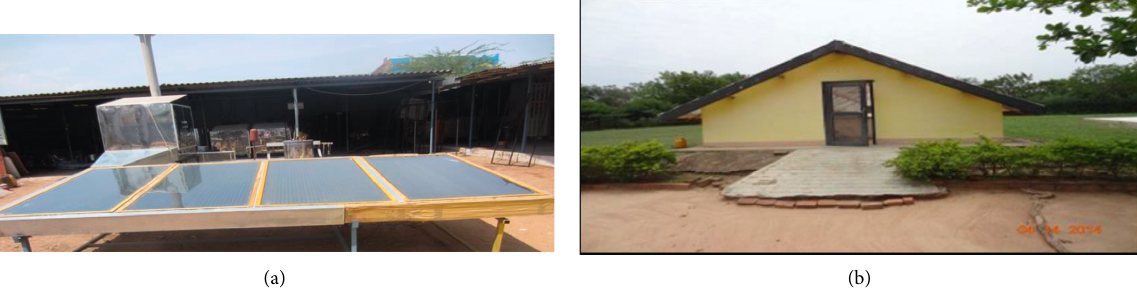
Figure 1: (a) Pictorial representation of the stainless steel solar dryer (SSSD). (b) Pictorial representation of the tent-like concrete solar dryer